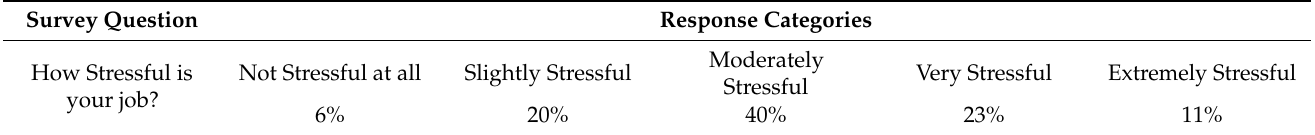
Table 3. Work stress survey results.